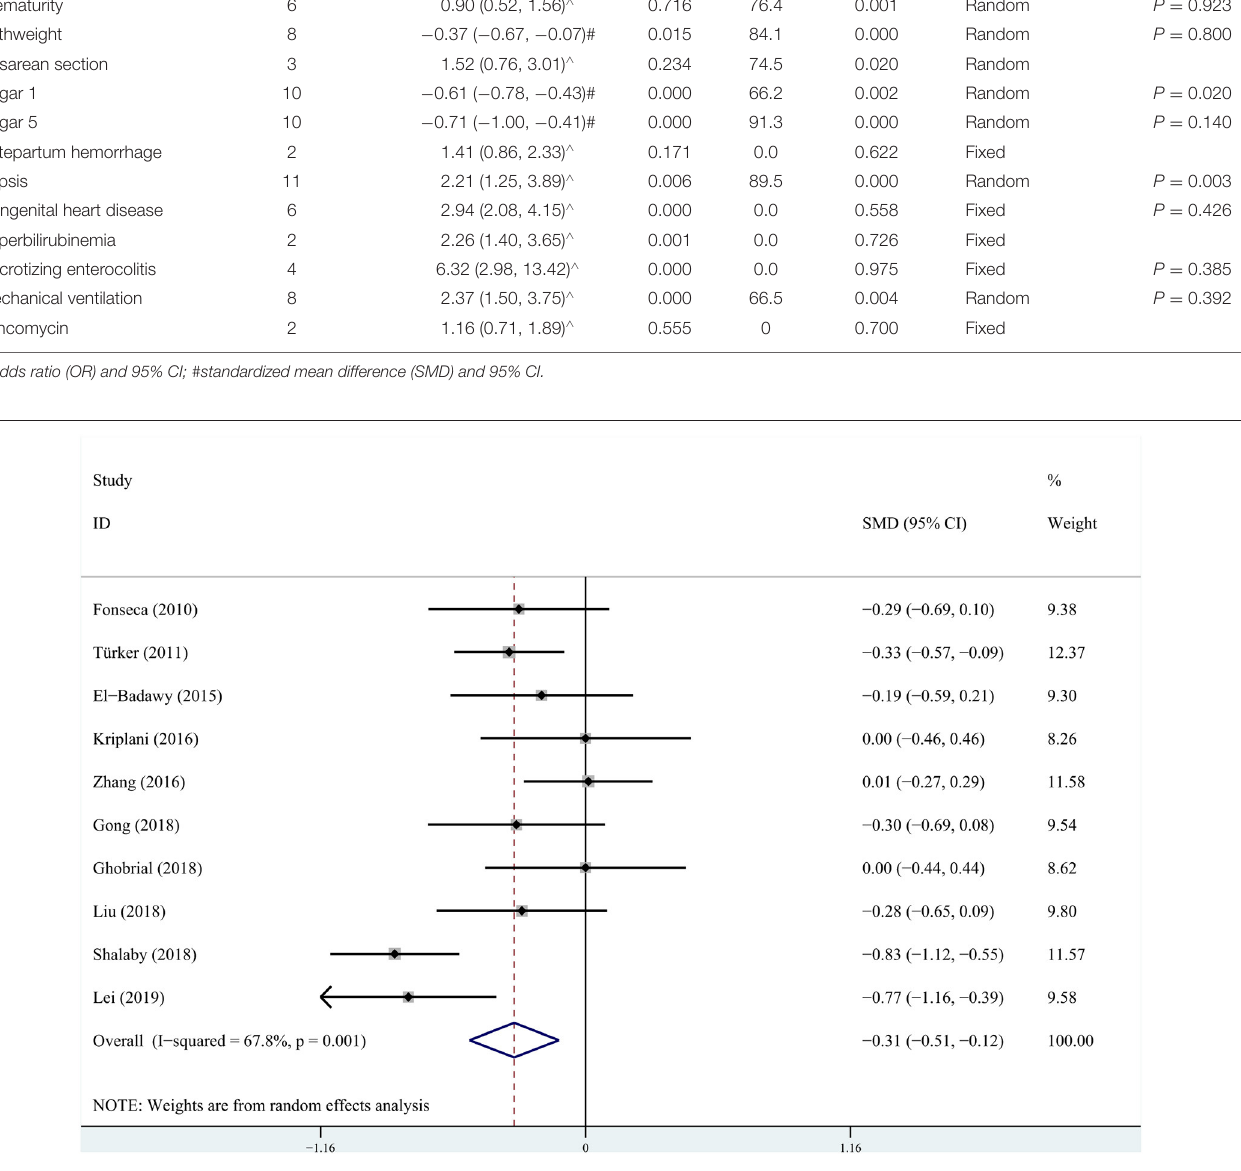
turn, used the random-effects models. As for male sex, prenatal hemorrhage, CHD, hyperbilirubinemia, NEC, and vancomycin, the heterogeneities were not significant, so fixed-effects models were used. Compared to the non-AKI group, the AKI group